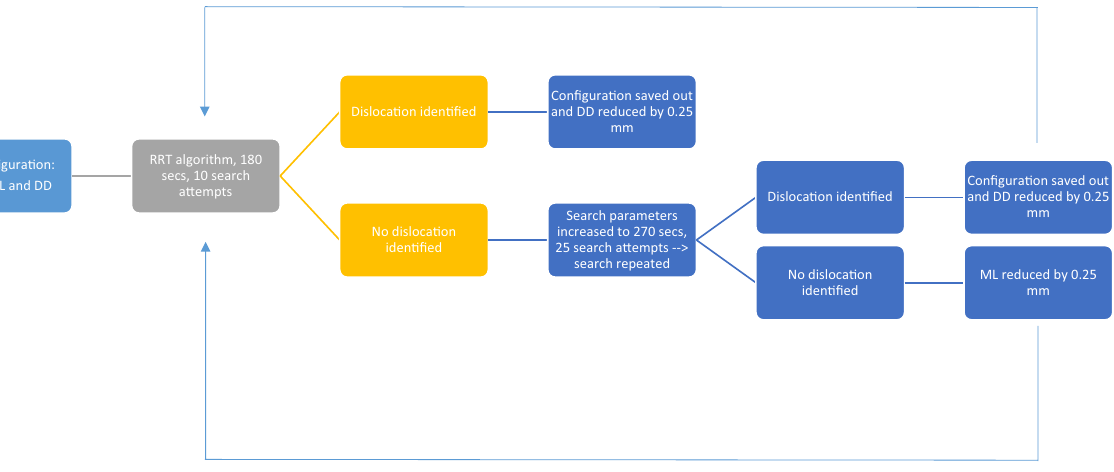
Figure 4. The coding loop used in the dislocation analysis tool for assessing